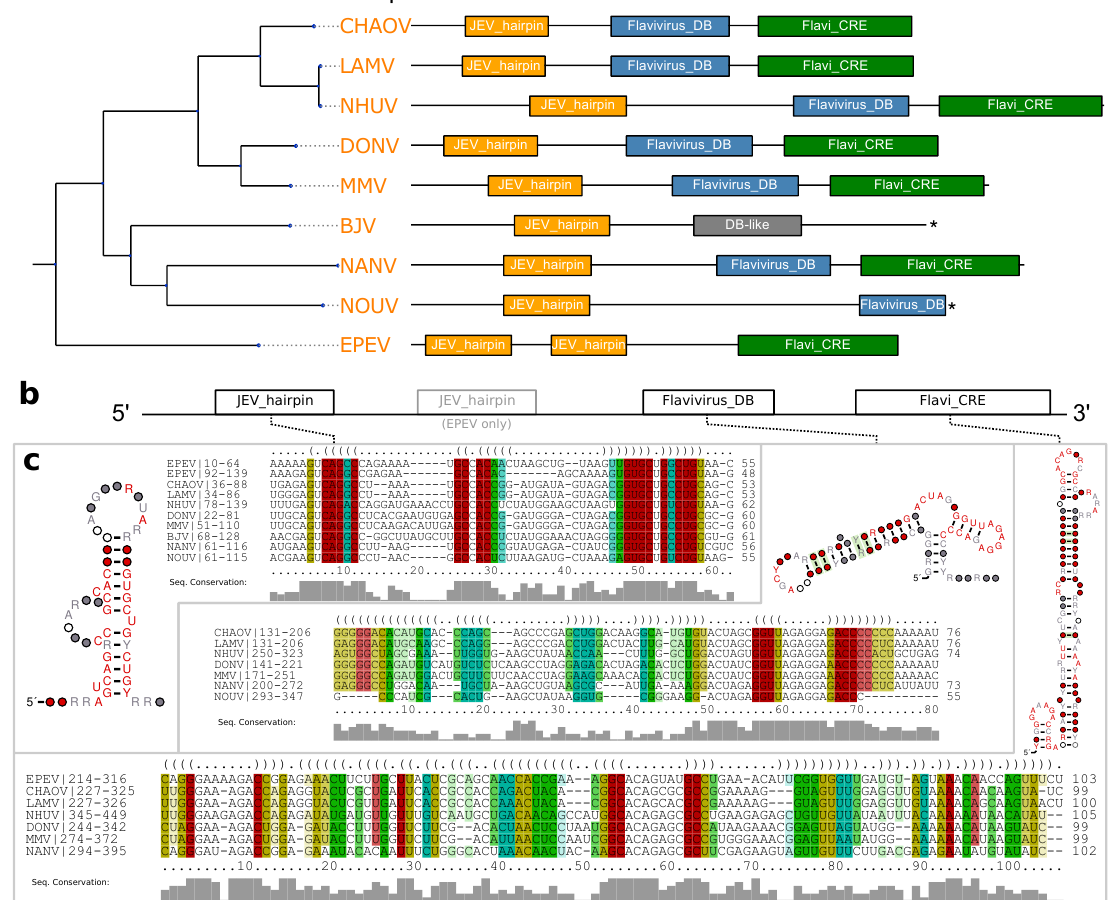
Figure 5. ( a ) Annotated Tree of dISFV 3 (cid:48) UTRs. Asterisks denote incomplete 3 (cid:48) UTR sequences. Species without available 3 (cid:48) UTR are not shown. ( b ) Schematic Architecture of the dISFV 3 (cid:48) UTR. ( c ) Structural alignments and consensus structure plots of dISFV